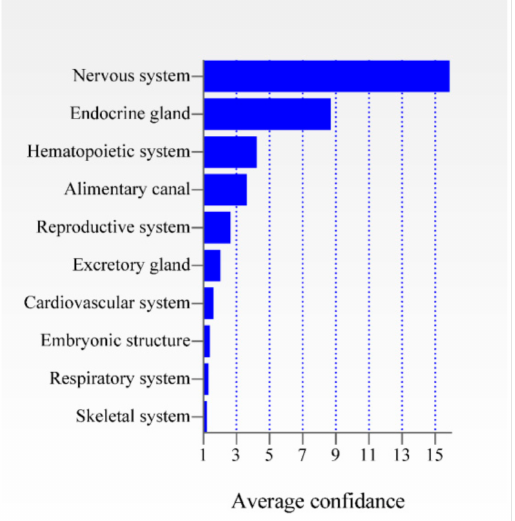
Figure 3. Expression of the 44 prioritized genes in ten different tissues. The average confidence value is shown for each